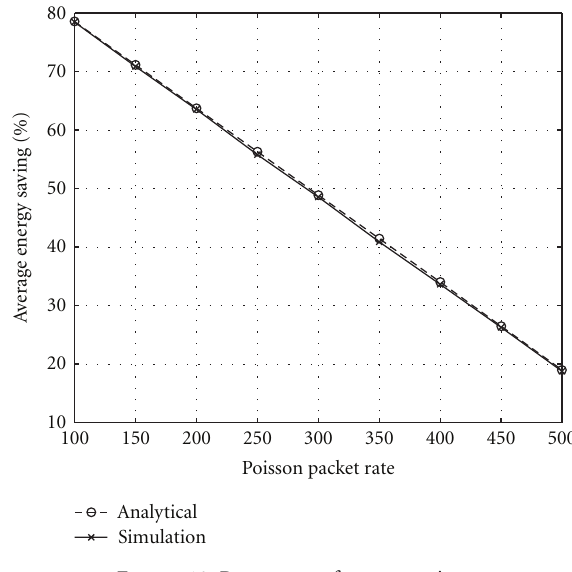
Figure 12: Percentage of energy saving.